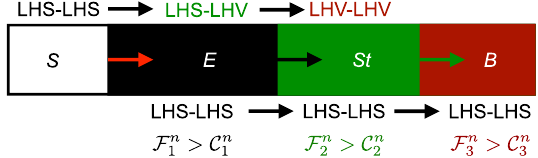
Figure 2. S , E , St , and B correspond to separable, entangled, steerable, and Bell nonlocal correlation, respectively. Entanglement, steerability, and Bell nonlocal correlation are confirmed if the observed correlation P of Eq. (1) can not be explained by the theoretical models LHS–LHS, LHS–LHV, and LHV–LHV, respectively. Less assumption about the associated systems makes the correlation more nonlocal. In this work, we discriminate the degree of nonlocality under a single theoretical model, LHS–LHS with the help of proposed uncertainty relation of inequality (2). Here, the violation of the inequalities F n 1 F n C n 3 ≤ 3 (4) validates entanglement, steerability and Bell nonlocal correlation,